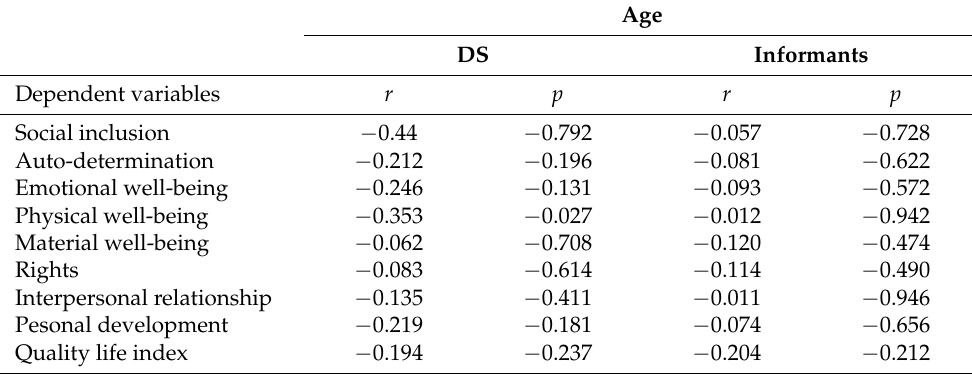
Table 3. Spearman’s Rho correlations between age of participants with DS ( n = 39) and self-perception with respect to the aspects of the study, and the correlation of these ages with informant perceptions ( n =